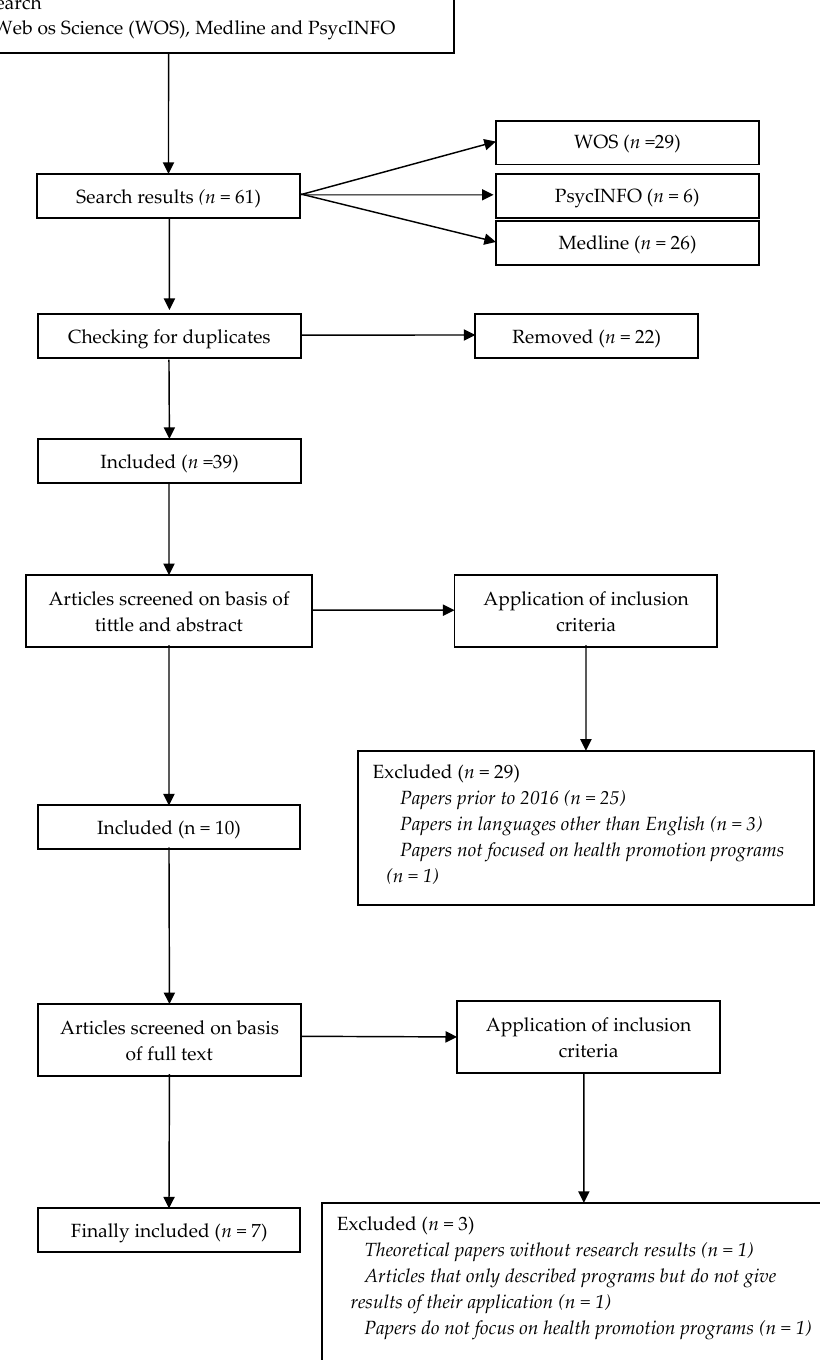
Figure 1. Flow chart